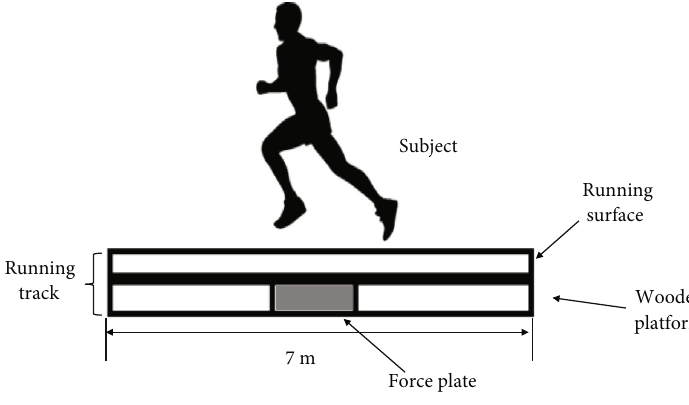
Figure 4: Schematic diagram of running